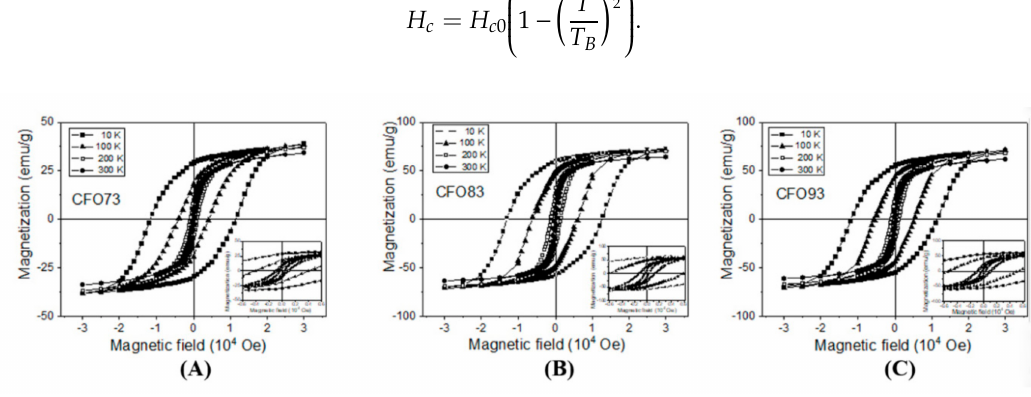
Figure 4. Hysteresis loops at selected temperatures in the range 10–300 K for samples CFO73 ( A ), CFO83 ( B ), and CFO93 ( C